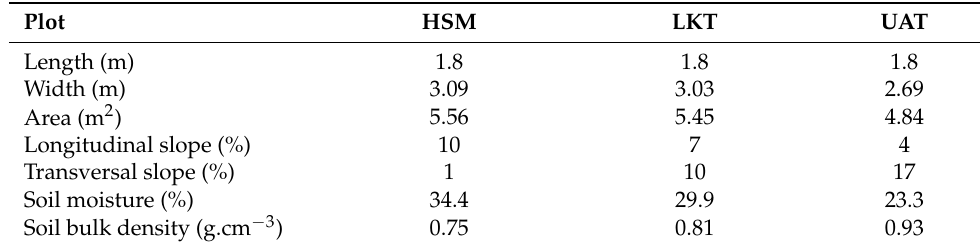
Table 3. Basic data about the sample plots.